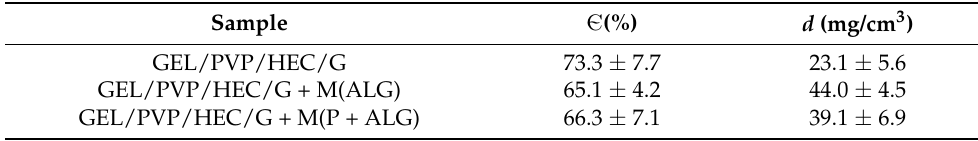
Table 2. Porosity ( Є ) and density ( d ) of GEL/PVP/HEC/G matrices containing microspheres (values with standard